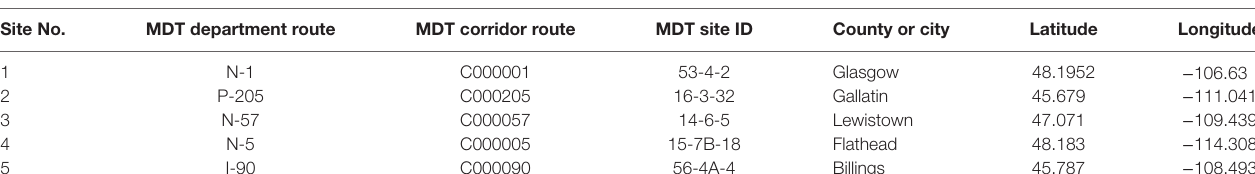
TaBle 7 | Description of selected sites per Montana Department of Transportation (MDT) records. site no.